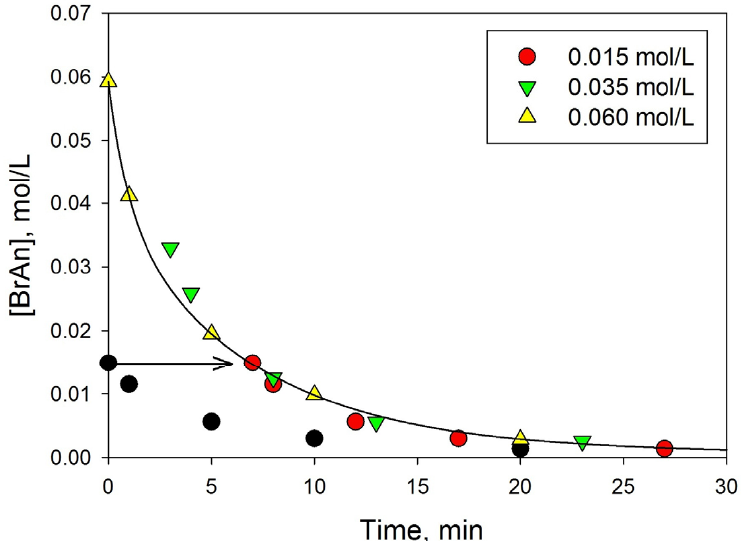
Figure 10. Dependence of the current concentration of BrAn on time in a series of experiments with different initial concentrations of [BrAn] 0 (yellow triangle—0.060 mol/L, green triangle—0.035 mol/L, red circle—0.015 mol/L) in the presence of Pd(0)/HPS.